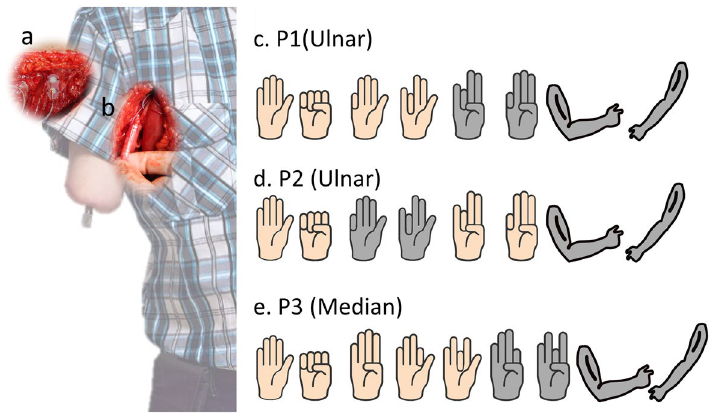
Figure 1. ( a ) Implanted muscular electrodes (biceps and triceps muscles), ( b ) extra-neural electrodes around the nerve (P1 and P2 Ulnar, P3 median), ( c–e ) hand gestures attempted by the subjects in their phantom hands. Grayed gestures only used in offline